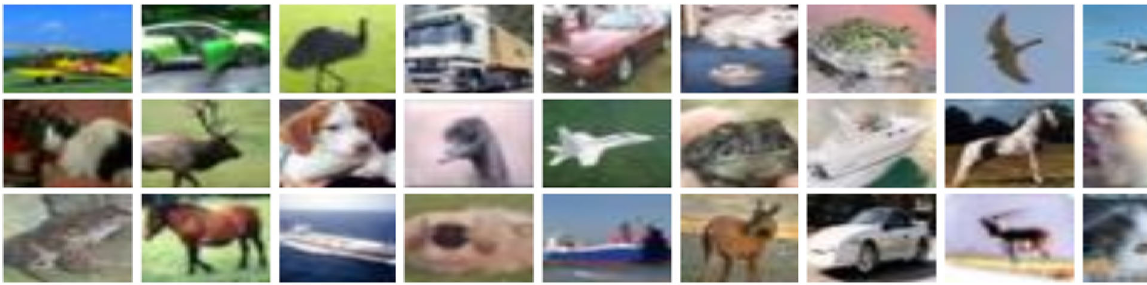
Fig. 3 Cifar 10 dataset sample images